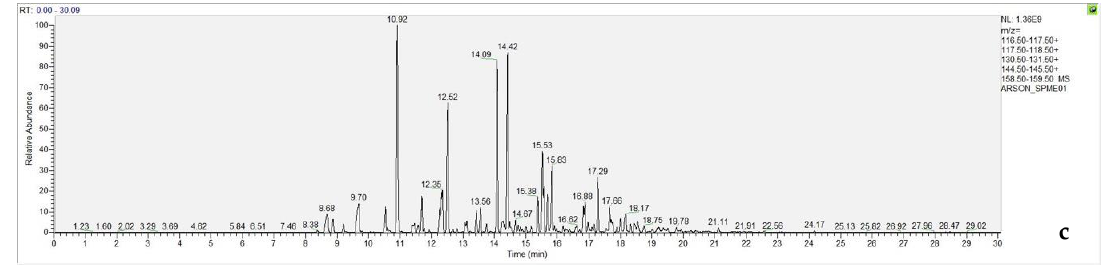
Figure 12. Extracted indane profiles of ( a ) carpet  3 burned without ILs; ( b ) carpet  3 burned with